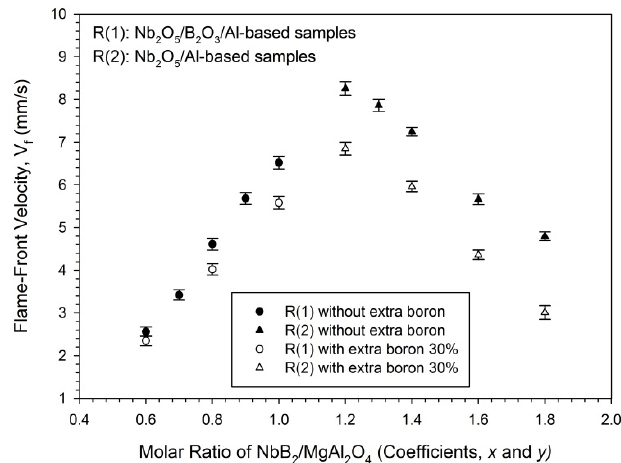
Figure 2. E ff ects of NbB 2 / MgAl 2 O 4 ratio and excess boron on flame-front propagation velocity of Figure 2. Effects of NbB 2 /MgAl 2 O 4 ratio and excess boron on flame-front propagation velocity of Reactions (1) and Reactions (1) and (2).